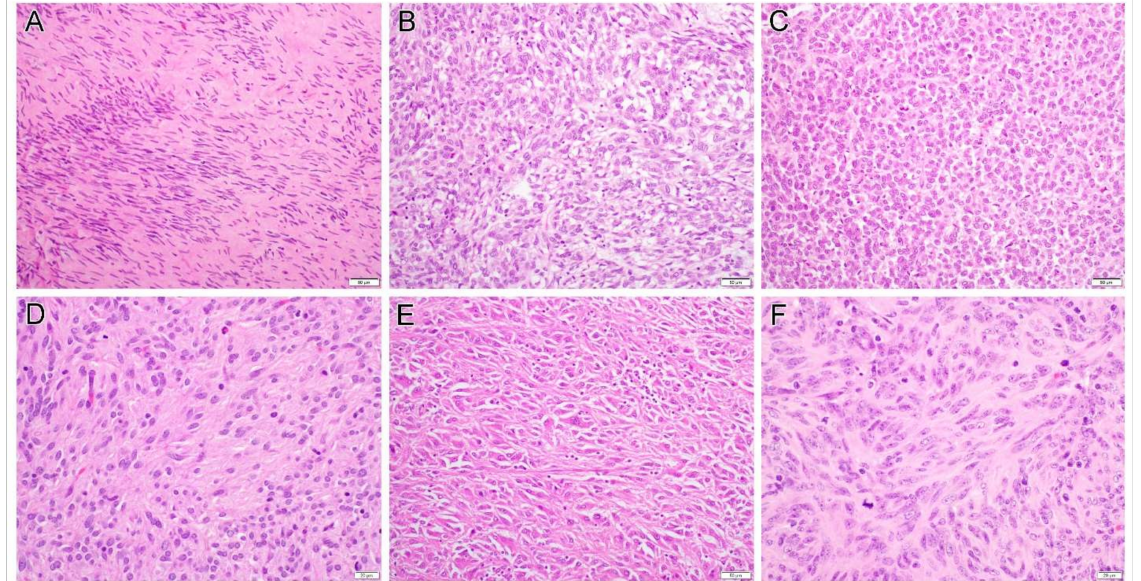
Figure 2. Examples of gastrointestinal stromal tumor histology include sclerosing spindle cell ( A , case 15), vacuolated ( B , case 2) or epithelioid ( C , case 2) morphology. Some tumors focally exhibited neuropil-like ( D , case 10), sarcomatoid appearance ( E , case 5) or significant cytologic